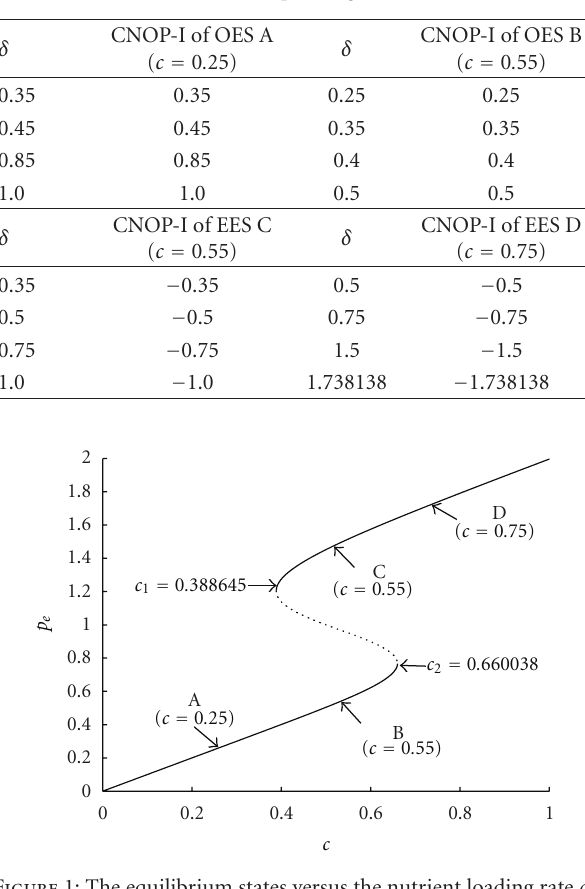
Table 1: The CNOP-Is corresponding to di ff erent basic states.